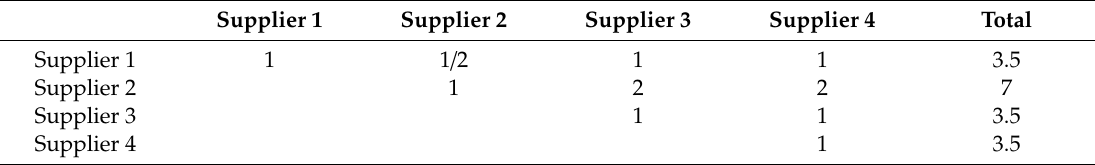
Table 6. The results of pairwise comparison for supplier alternatives with regard to financial strength